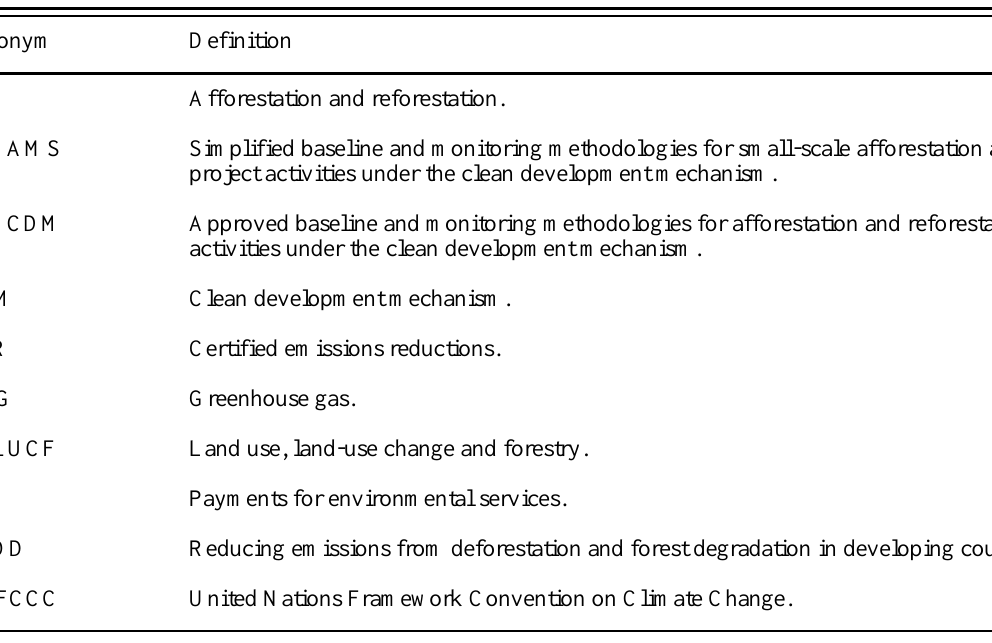
Table 1. List of acronyms used in CDM literature (UNFCCC